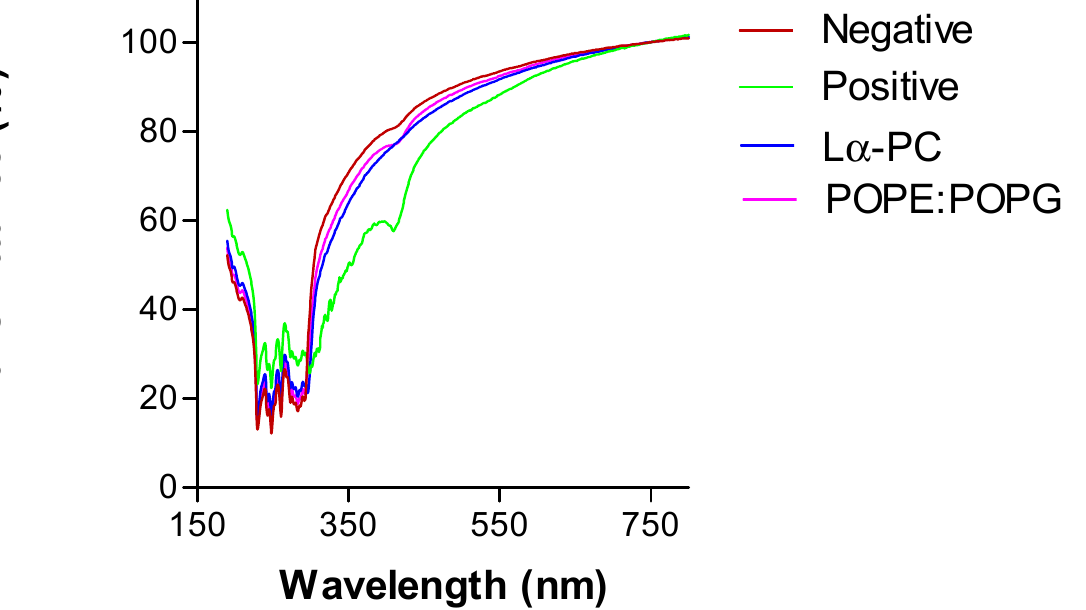
Figure 11. Transmittance from 190 to 850 nm wavelength of the corneas treated with PBS (negative control), ethanol (positive control), L α -PC (L- α -phosphatidylcholine), and POPE:POPG liposomes (L α -PC = L- α -phosphatidylcholine; POPE:POPG = 1-palmitoyl-2-oleoyl-phosphatidylethanolamine: 1-Palmitoyl-2-oleoyl-sn-glycerol-3-phosphoglycerol (3:1, mol/mol) after 10 min of incubation.